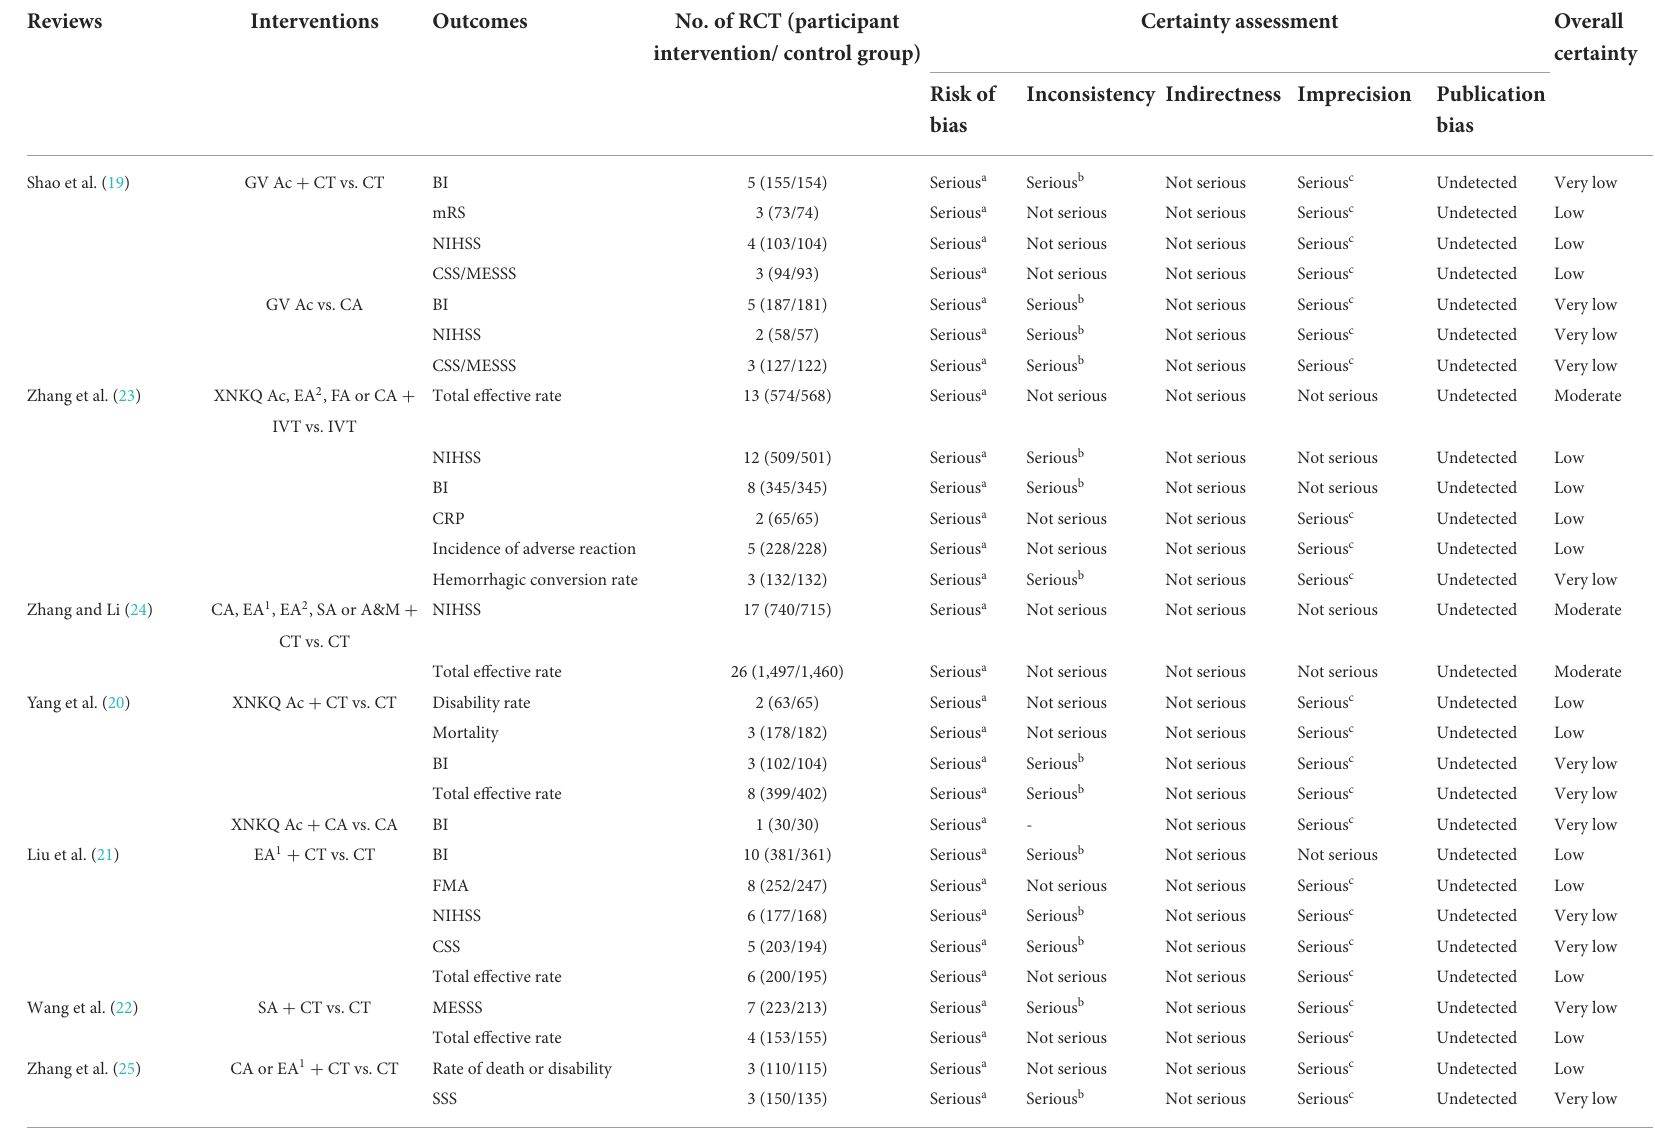
TABLE 3 Certainty of evidence in included SRs by